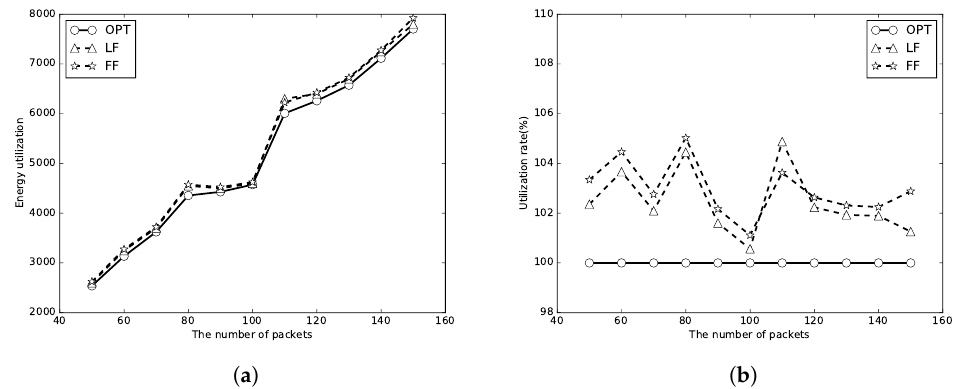
Figure 9. C = 2 E . ( a ) energy utilization; ( b ) energy utilization ratio.